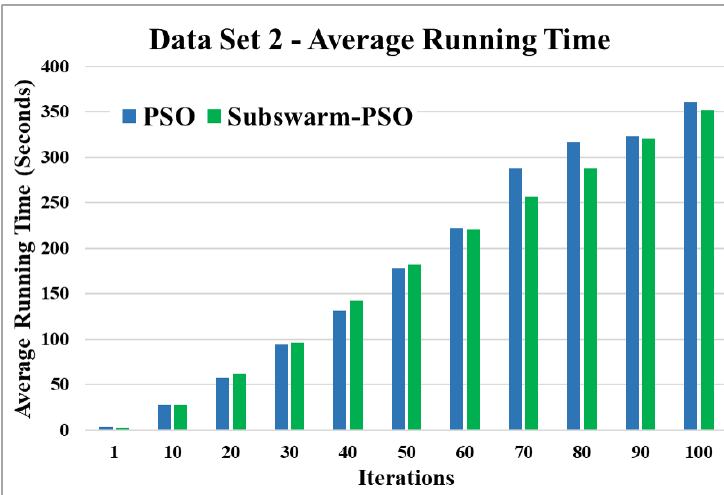
Figure 8. Average running time for data set 2.